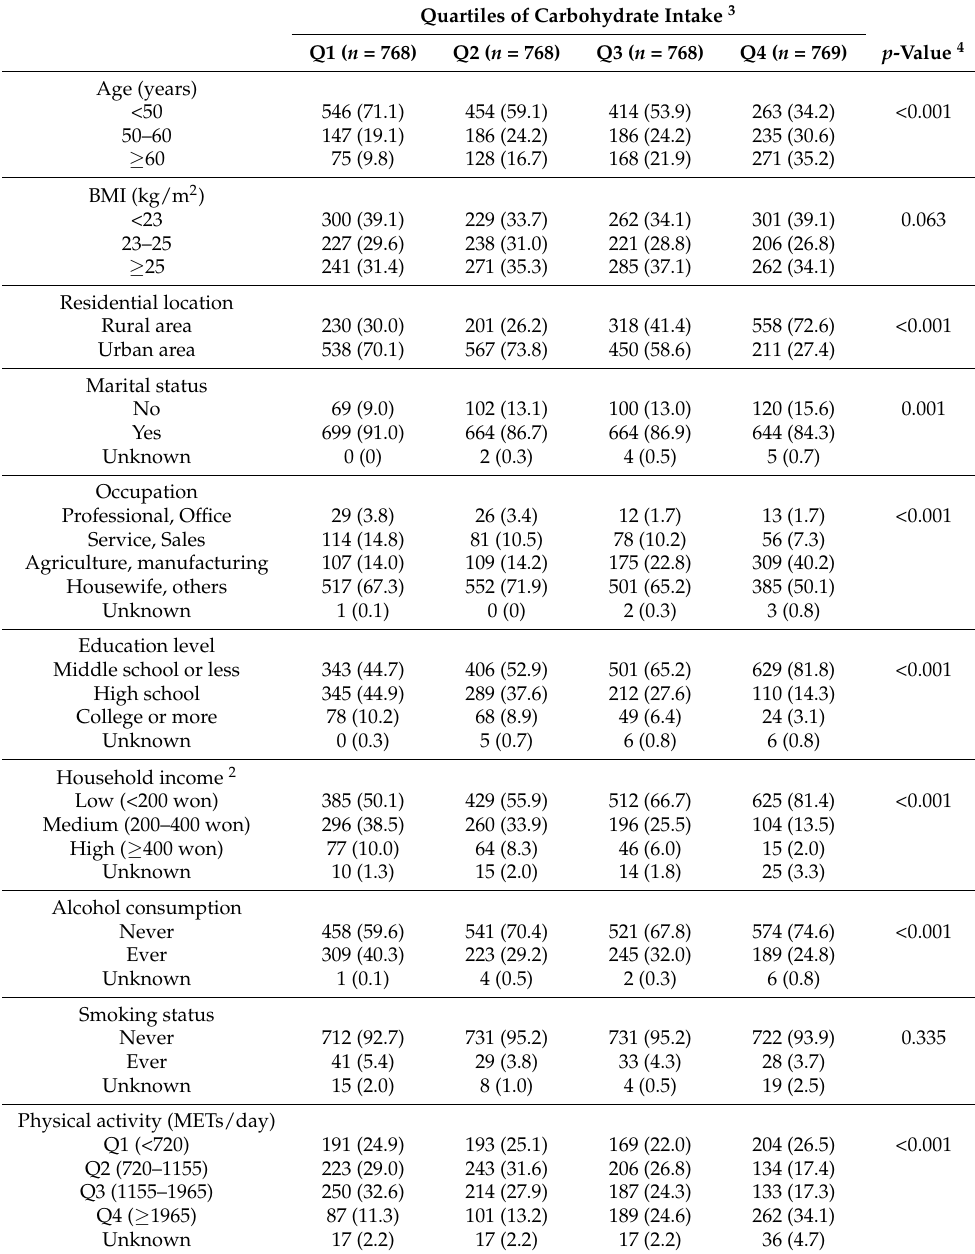
Table 2. General characteristics of the study participants according to the quartiles of carbohydrate intake in controls 1